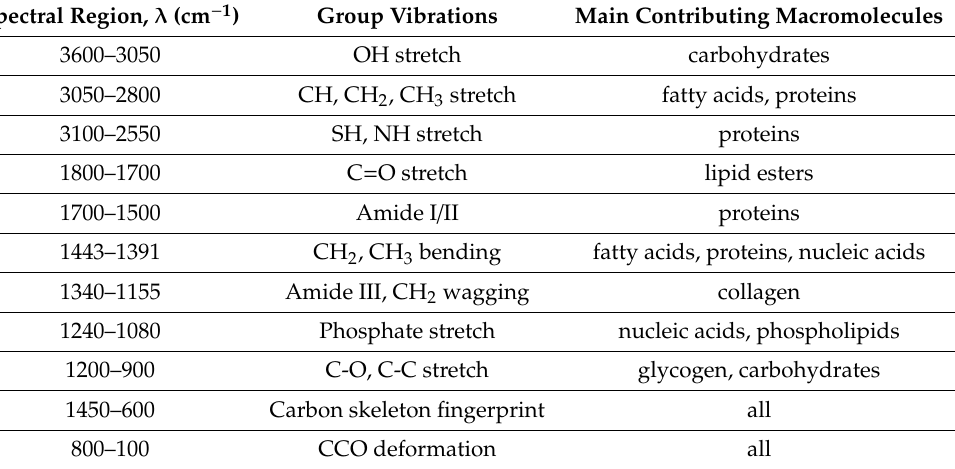
Table 1. Main Fourier-transform infrared (FTIR) spectral regions and group vibrations present in the biological